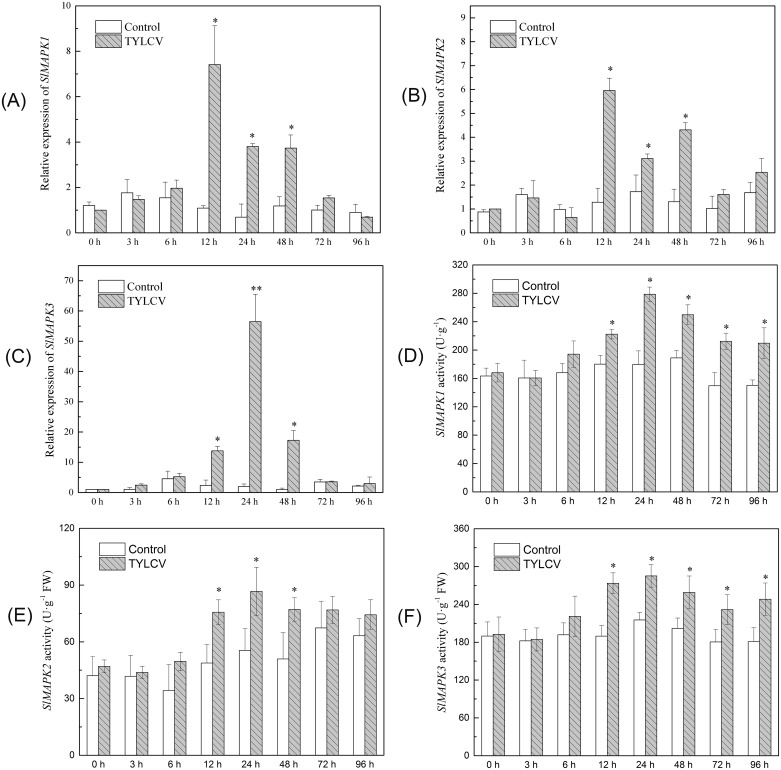
The RNA expression and protein activity of SlMAPK1, SlMAPK2 and SlMAPK3 were analyzed in ‘Y19’ tomato leaves following TYLCV infection.Samples were collected from the uppermost leaves at different times after TYLCV inoculation. The samples were used to extract RNA, which was reverse transcripted into cDNA to detect the relative expression of SlMAPK1 (A), SlMAPK2 (B) and SlMAPK3 (C) by qRT-PCR. The tomato SlEF1α gene was used as an internal control [59, 64]. The expression levels are relative to 0 h post infection. The activities of SlMAPK1 (D), SlMAPK2 (E) and SlMAPK3 (F) were determined with an ELISA kit (Shanghai Biological Technology Co., Ltd.). Values are means ± standard error (SE), replicated thrice. The treatments were compared with the control using Tukey’s test. * Significant at P<0.05, ** Significant at P<0.01.